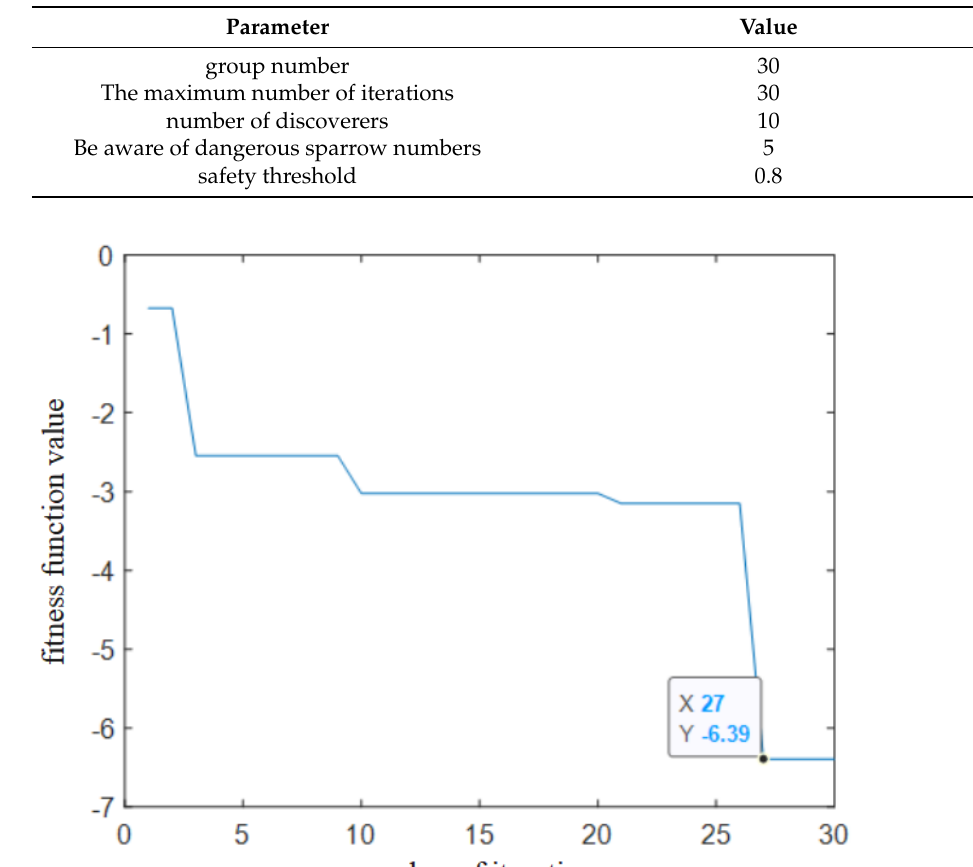
Table 2. Parameter settings of the SSA.